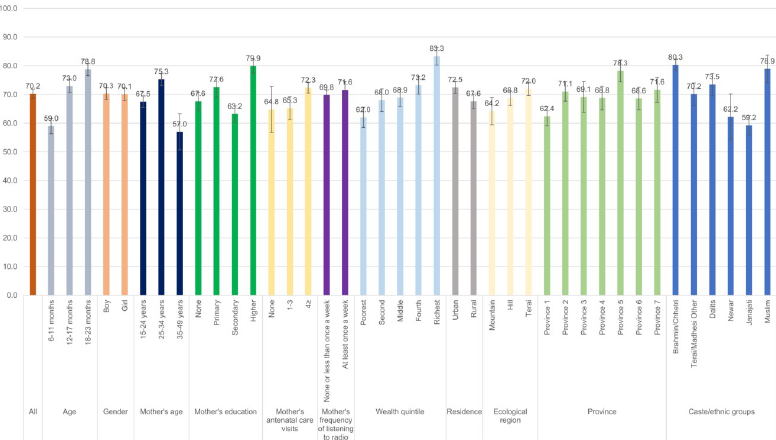
Fig 2. Percentage of Nepalese children aged 6 to 23 months consuming legumes and nuts by sociodemographic factors.